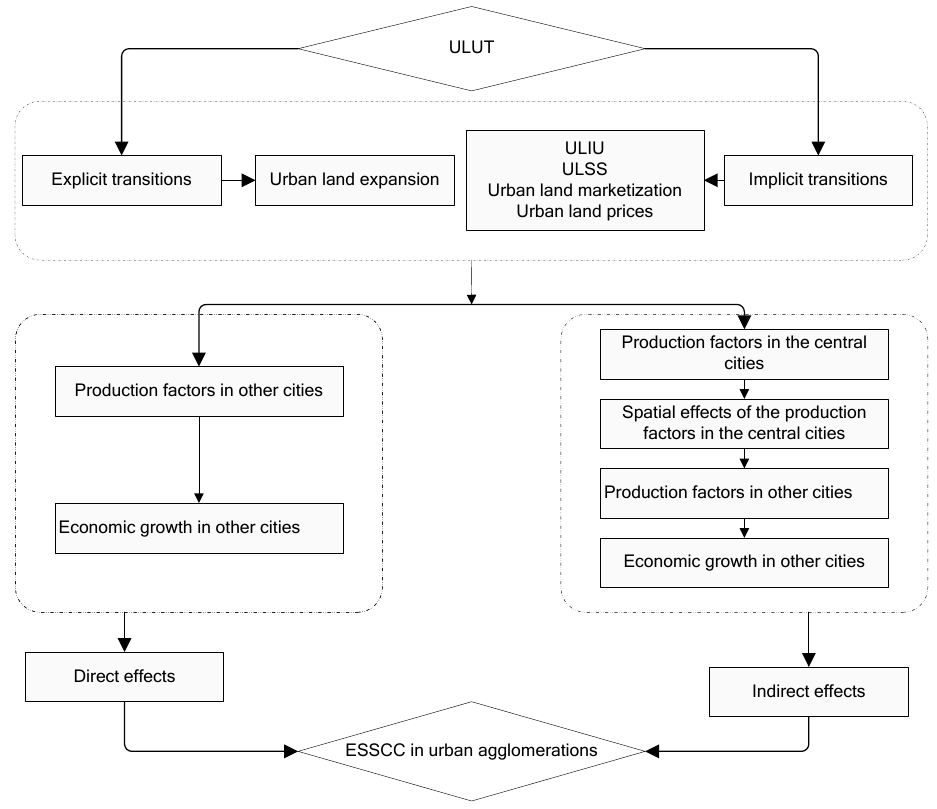
Figure 1. The influence mechanism of ULUT on the ESSCC in urban agglomerations.